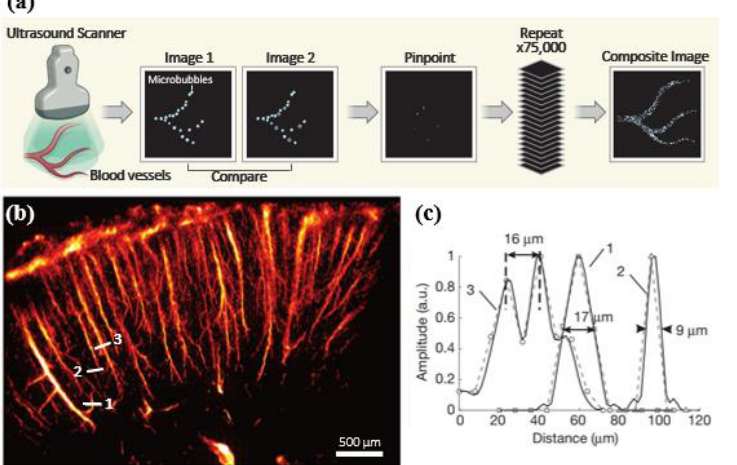
Figure 1. ( a ) An illustration of the concept of SRU imaging (reprinted with permission from Ref. [44]. Copyright 2015 Springer Nature). ( b ) The reconstructed super-resolved brain microvasculature with the resolution of λ /10 [29]. ( c ) Interpolated profiles along the marked lines (reprinted with permission from Ref. [29]. Copyright 2015 Springer Nature).